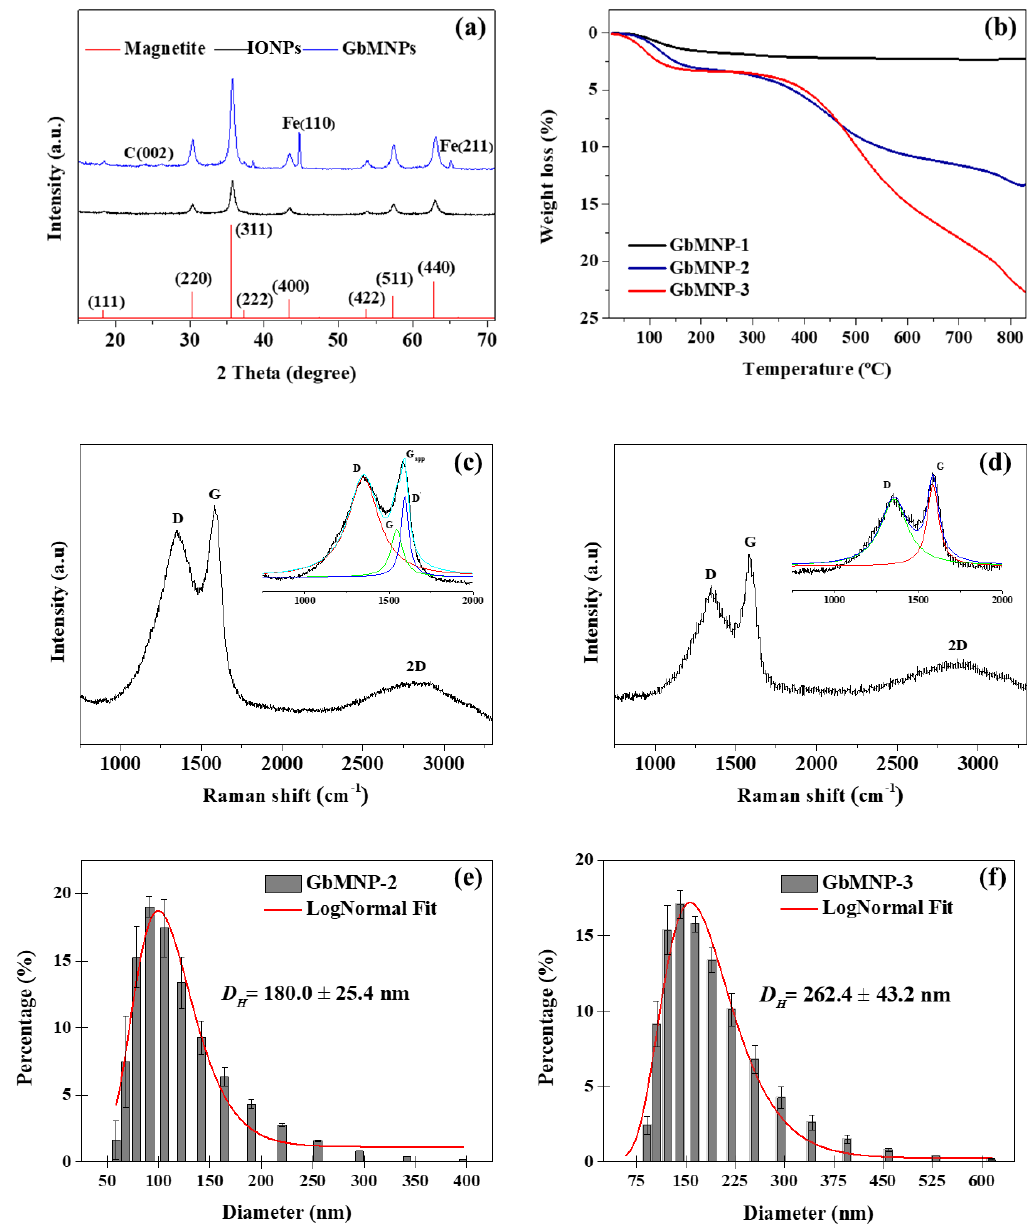
Figure 3. The physicochemical characterization of GbMNPs: ( a ) Wide-angle powder X-ray diffraction (XRD) patterns of iron oxide nanoparticles and GbMNP-2; ( b ) Thermogravimetric analysis of the as-synthesized GbMNPs (GbMNP-1, GbMNP-2, and GbMNP-3); Raman spectrum of the as-synthesized GbMNPs with an inset corresponding to the deconvolution of the observed D and G ( c ) GbMNP-2; ( d ) GbMNP-3; Dynamic light scattering (DLS) measurements with average hydrodynamic diameter (D H ) of ( e ) GbMNP-2; ( f ) GbMNP-3.